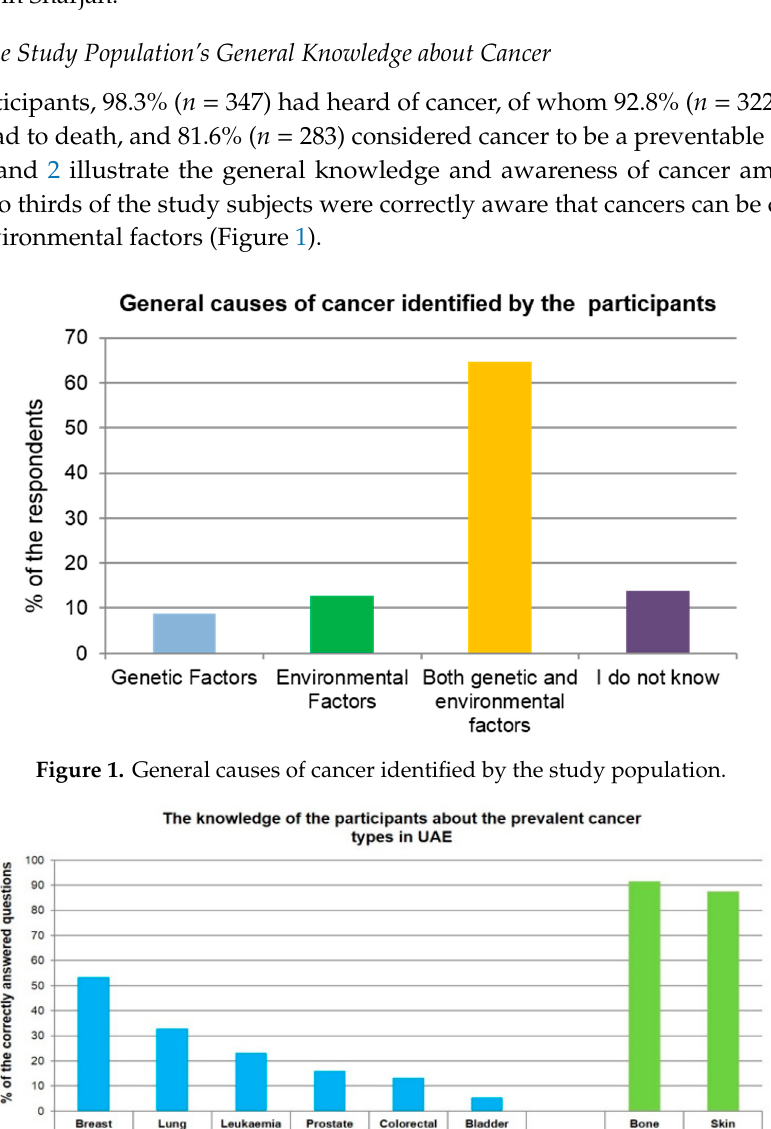
Figure 2. The knowledge of the participants regarding the prevalent cancer types in the UAE.